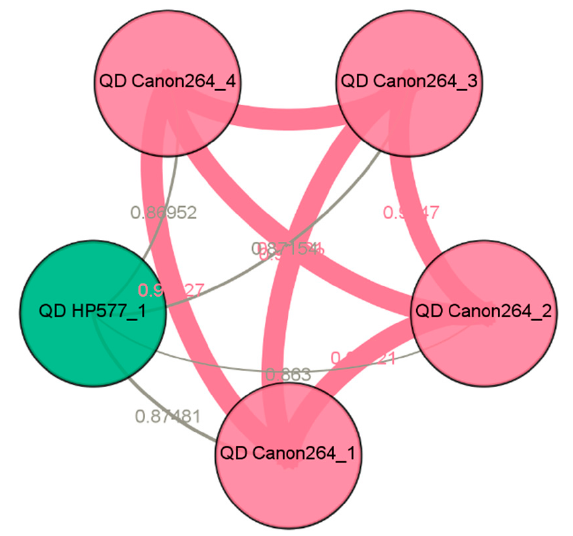
Figure 3. Test 3 visualization of a single document with questionable parts.